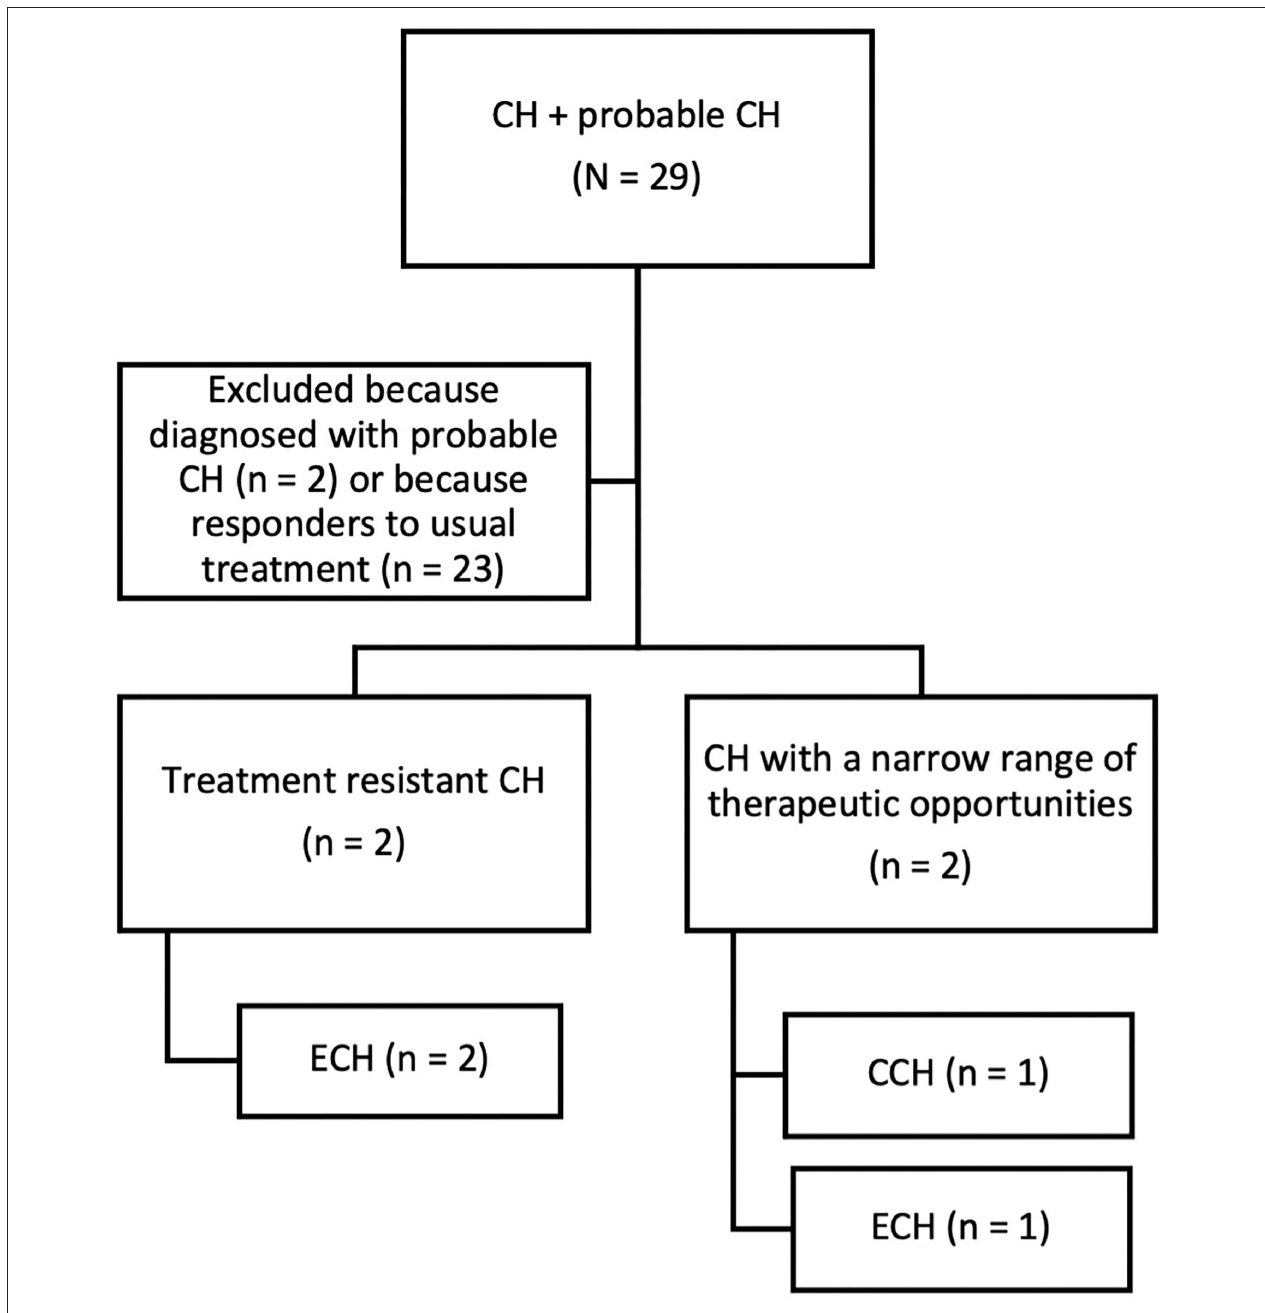
FIGURE 2 | Flow chart of retrospective patients’ selection. CH, Cluster Headache; CCH, Chronic Cluster Headache; ECH, Episodic Cluster